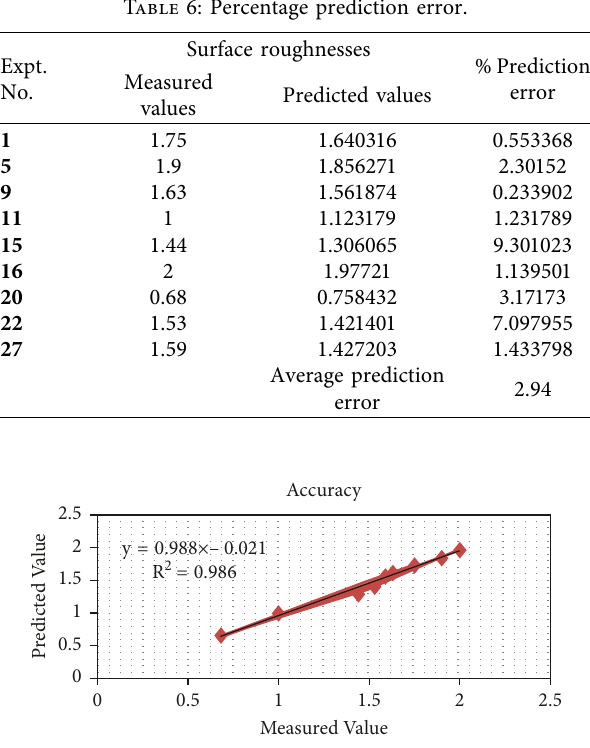
Figure 4: Accuracy plot of the CFNN model.